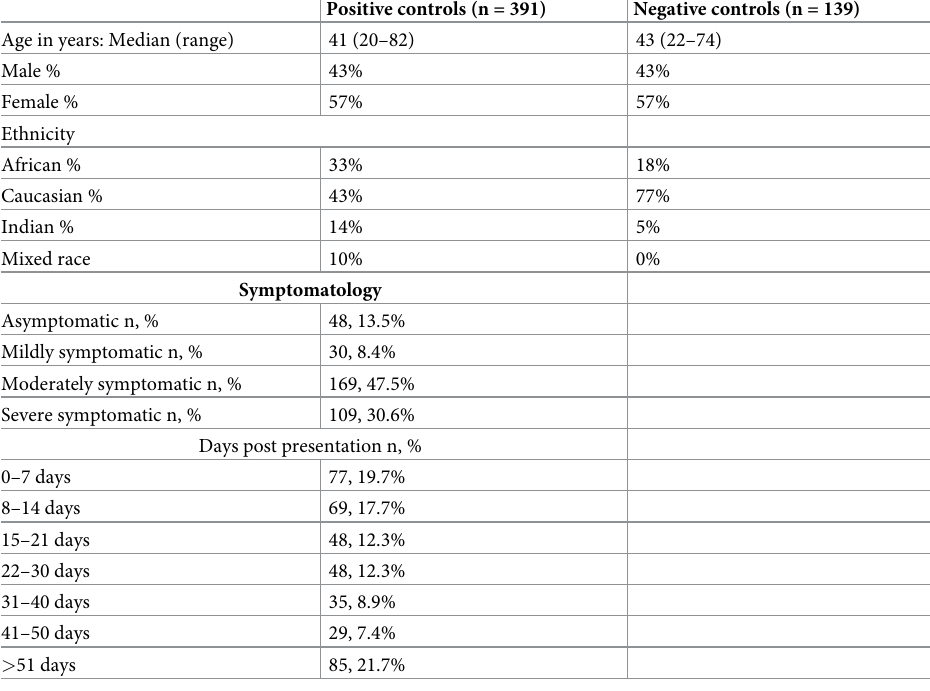
Table 2. Participant